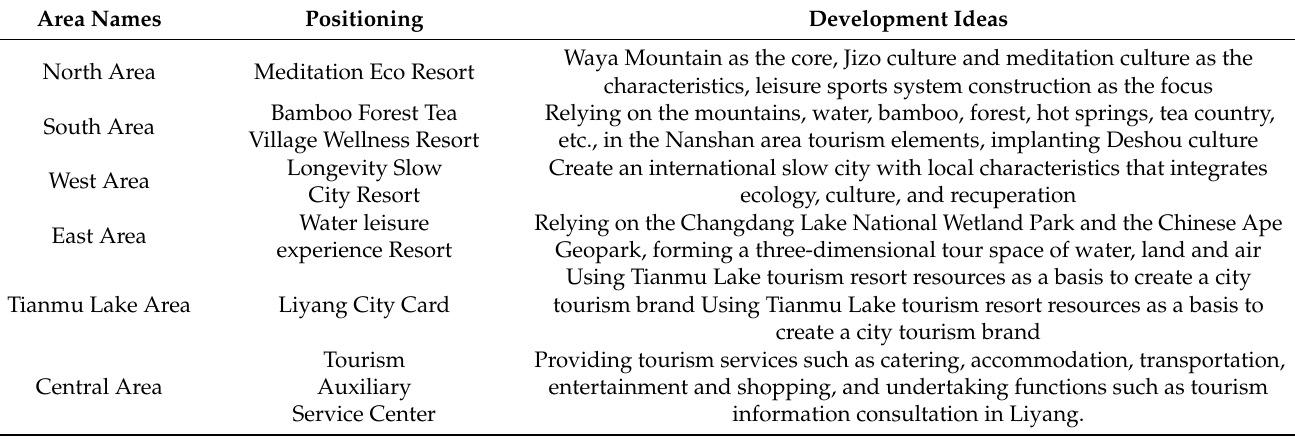
Table 3. List of tourism development plans of each area in Liyang.